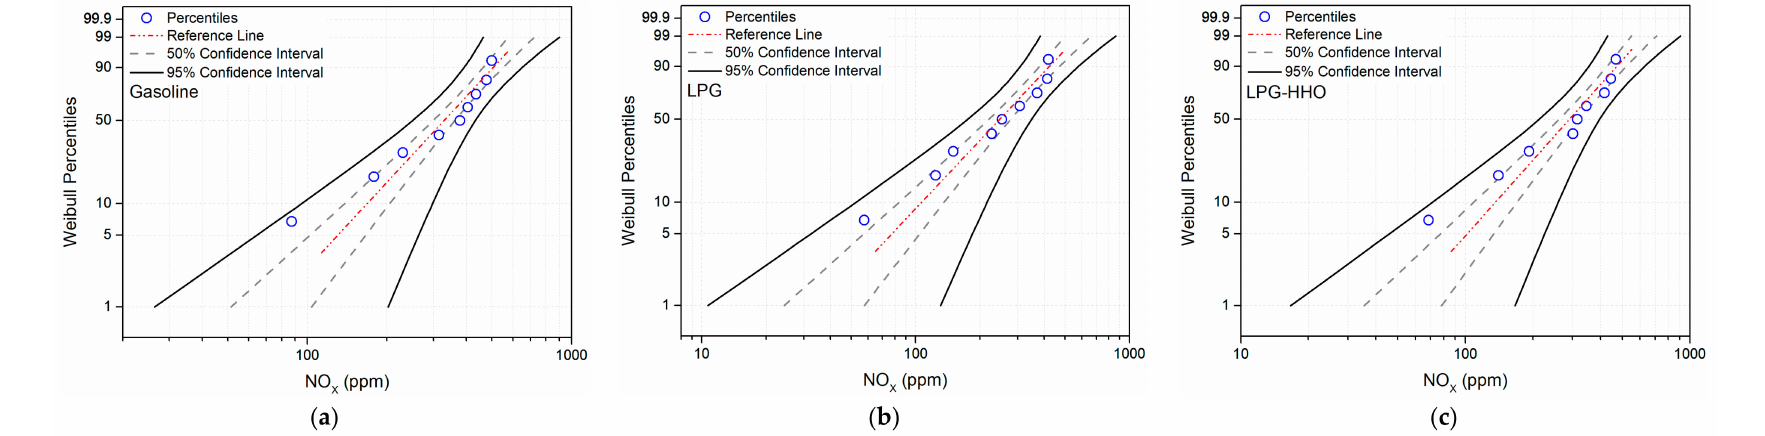
Figure 8. ( a – c ) Weibull probability plot of NO X for 50% and 95% CI using gasoline, LPG and LPG-HHO